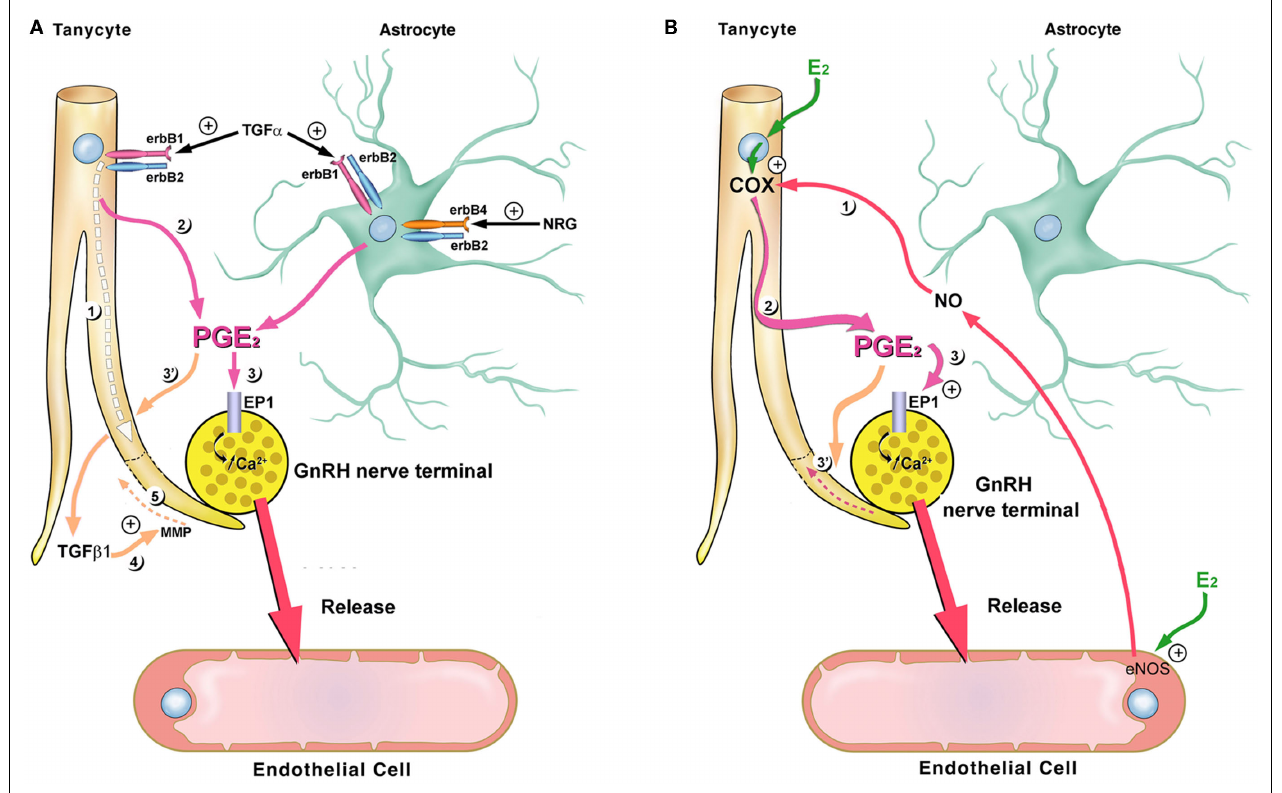
FIGURE 7 | Schematic representation of neural–glial–endothelial interactions involved in the control of GnRH neurosecretion in the median eminence. (A) Glial–neuronal interactions in the median eminence involve the production of epidermal growth factor (EGF)-related peptides by glial cells. Activation of erbB1/erbB2 and erbB4/erbB2 heterodimers byTGF α and NRG, respectively, promotes the release of PGE 2 from astrocytes.The binding ofTGF α to tanycytic erbB1 receptors results in the recruitment of erbB2 co-receptors and signal transduction.The ligand-dependent activation of erbB1 receptors in tanycytes results in biphasic plastic changes characterized by an initial phase of tanycyte outgrowth (1) and a secondary phase of retraction (5). Although the initial outgrowth (1) is independent of the TGF β 1 system, the subsequent retraction requires PGE 2 synthesis (2), a PGE 2 -dependent increase in the production ofTGF β 1 (3 (cid:2) ) and matrix metalloproteinase (MMP) activity (4). In addition to promotingTGF β 1 synthesis by tanycytes (3 (cid:2) ), PGE 2 released by tanycytes (2) and astrocytes is